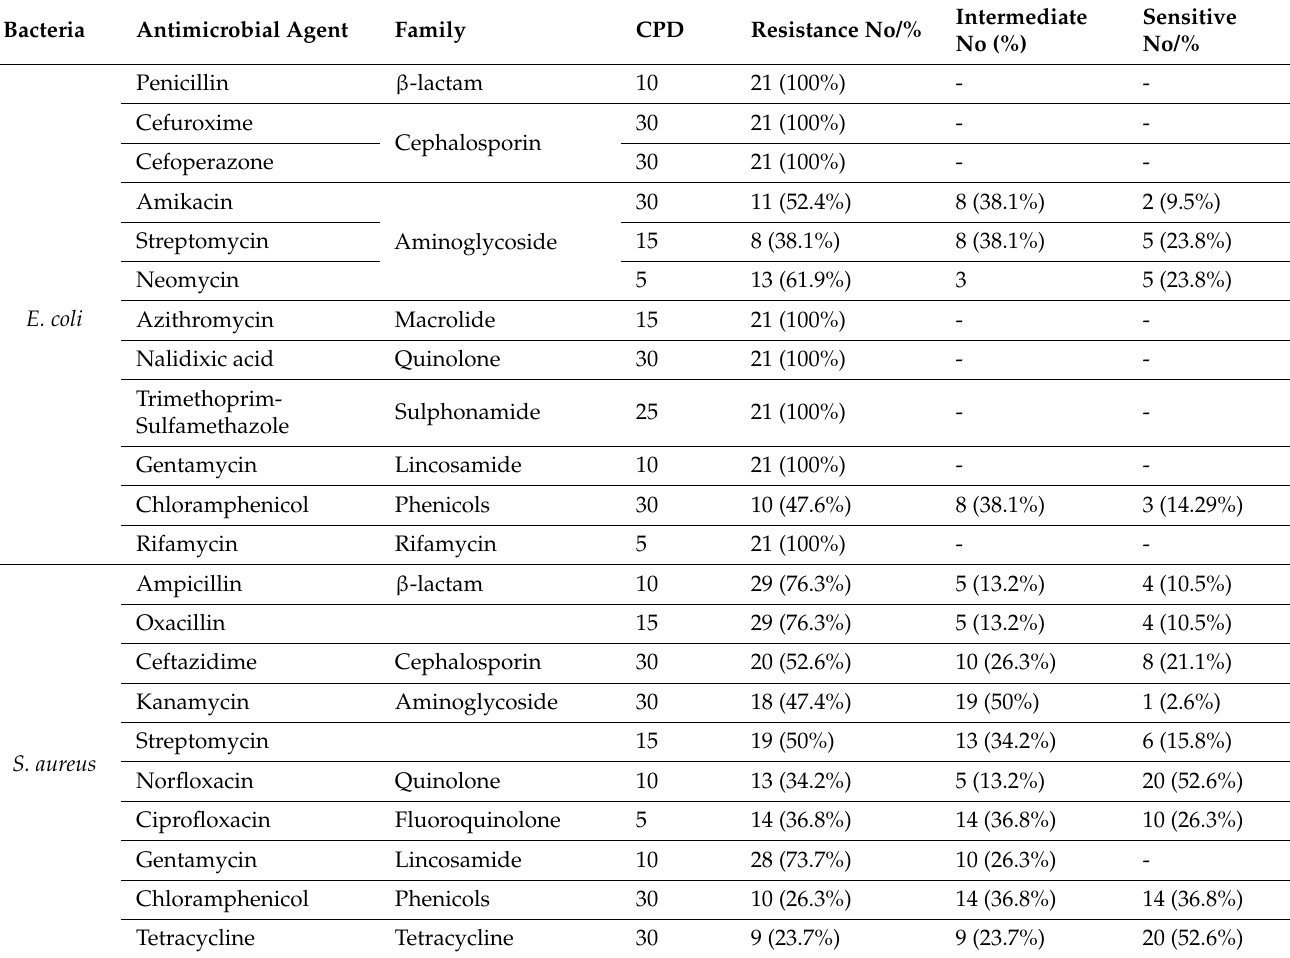
Table 2. Antimicrobial sensitivity detected in different Escherichia coli and Staphylococcus aureus isolates from clinical and sub-clinical mastitic